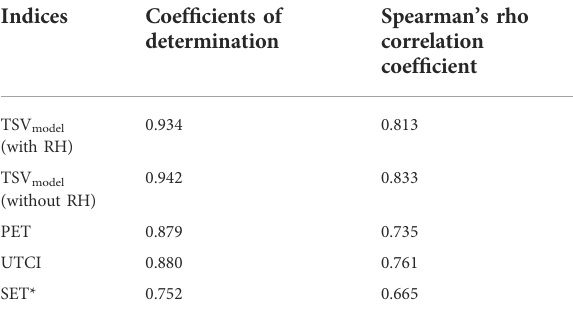
TABLE 6 Coef fi cient of determination and Spearman ’ s rho correlation coef fi cient. Indices